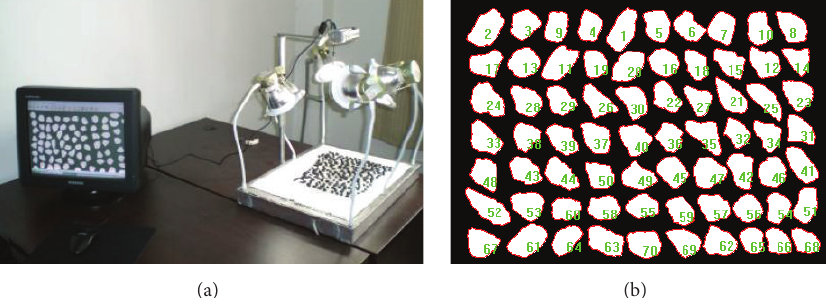
Figure4:Illustrationoffractaldimensionmeasurement:(a)MorphologyAnalysisSystemforCoarseAggregates(MASCA)and(b)boundary identification of aggregates.